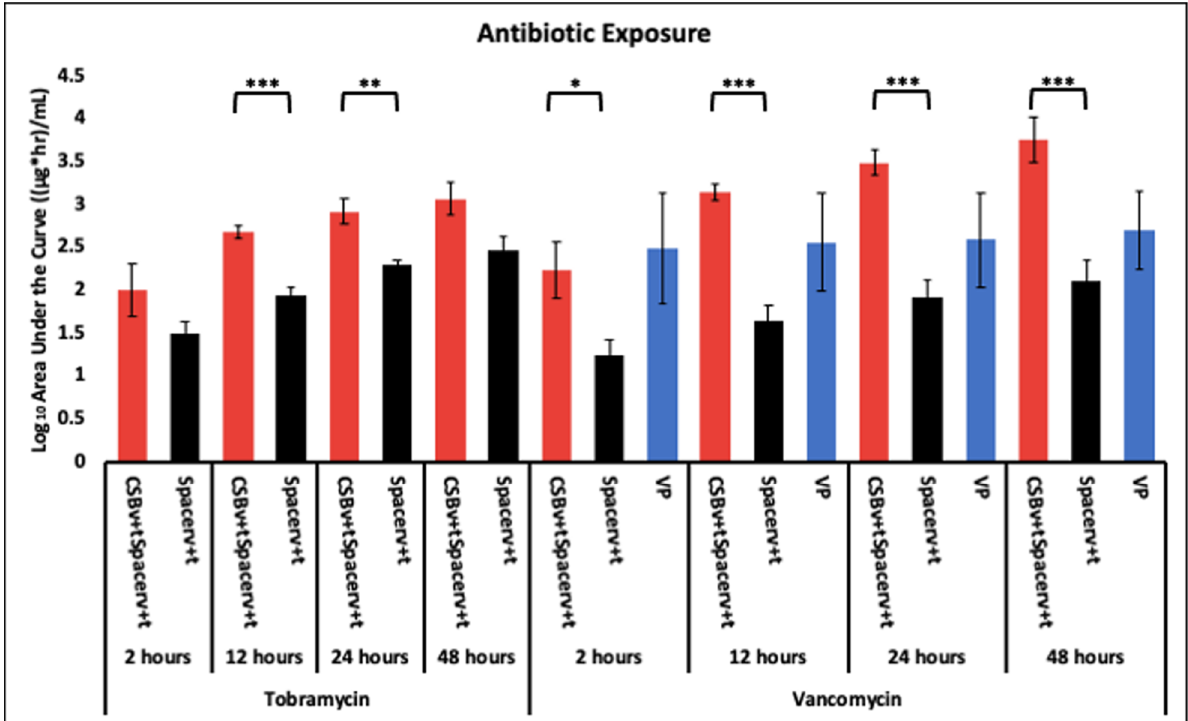
Figure 5. Tobramycin and vancomycin exposure via antibiotic administration methods to the system at 2, 12, 24 and 48 h. N = 4 replicates for Spacerv+t and CSBv+tplusSpacerv+t and 3 for VP; geometric mean ± 1 SE. (* p < 0.05, ** p < 0.01, *** p < 0.001). The same data shown on a linear Y-axis scale are available in supplemental material (Figure S1).